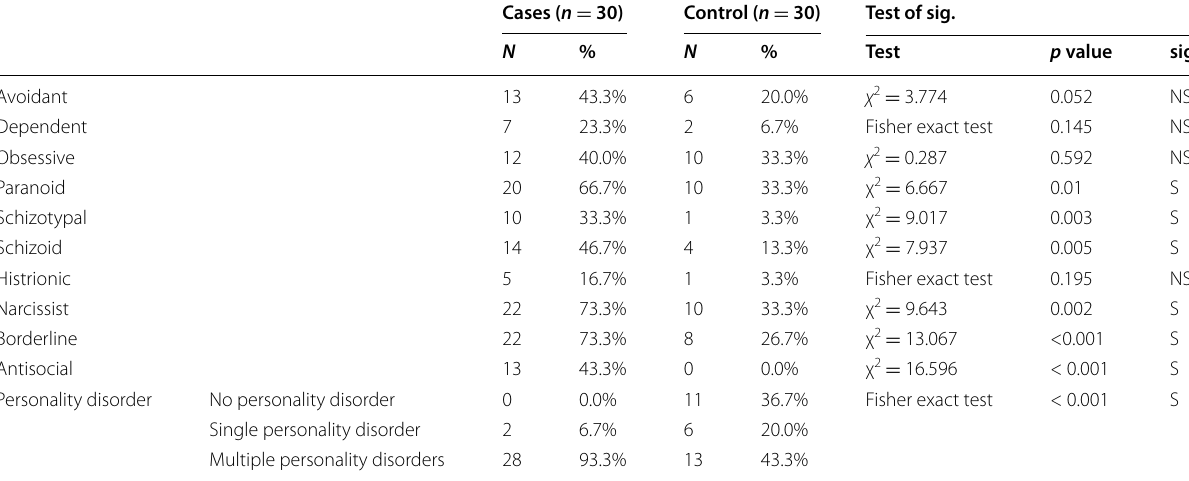
NS non-significant, S =